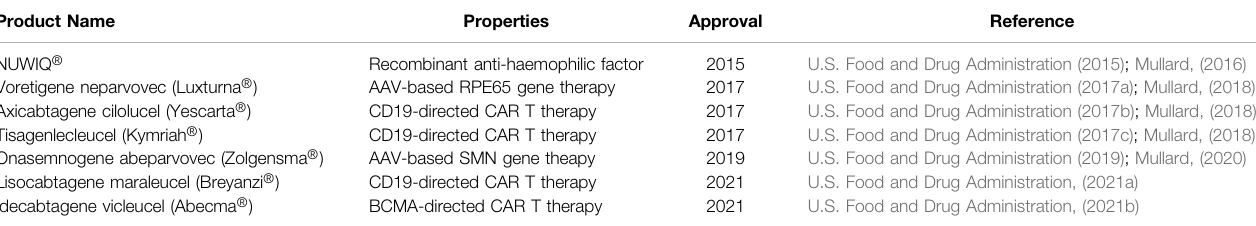
TABLE 1 | FDA-approved biologics produced in HEK293 since